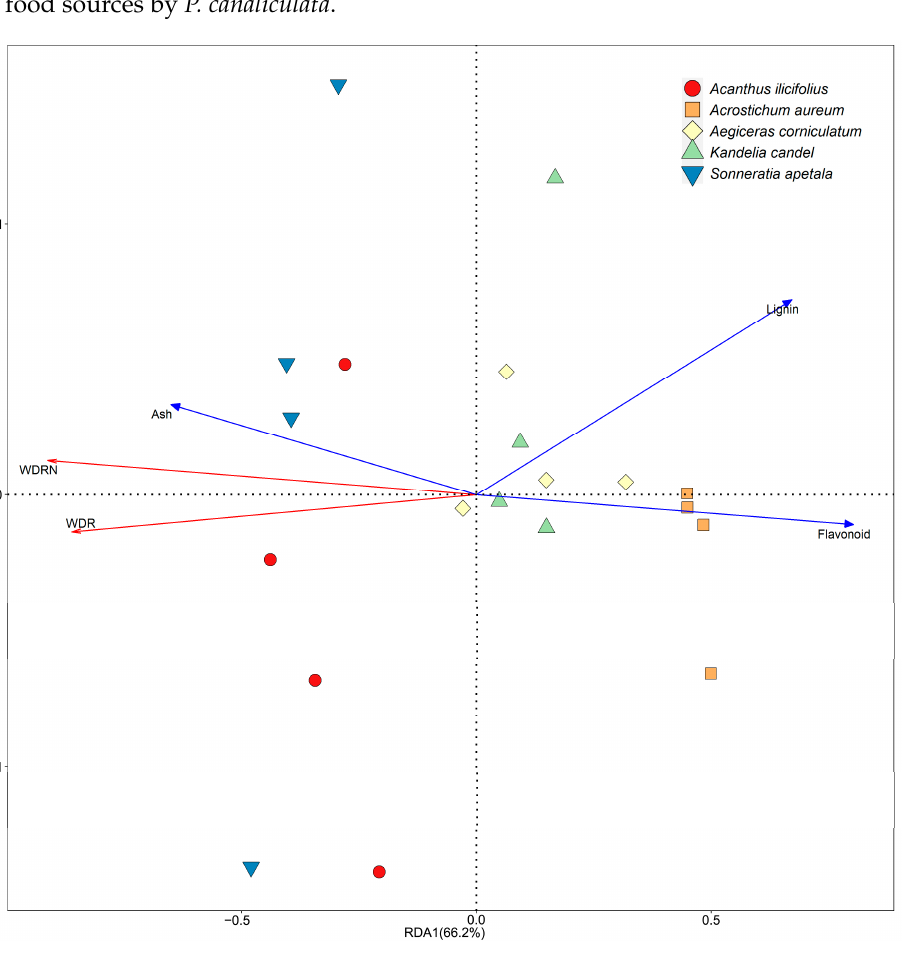
Figure 3. Redundancy analyses (RDA) of the correlations between feeding indicators and chemical characteristics of decaying leaf litter of five species of mangroves. WDR (g g − 1 d − 1 )—weight-specific daily feeding rate under the multiple-choice condition; WDRN (g g − 1 d − 1 )—weight-specific daily feeding rate under the no-choice